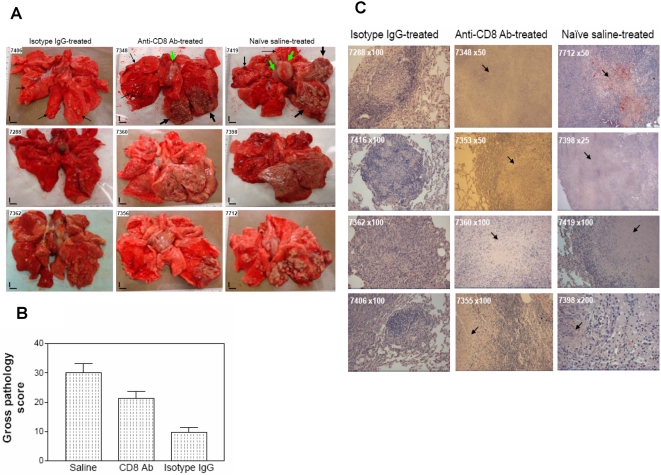
Depletion of CD8 lymphocytes in CD8 Ab-treated macaques resulted in a significant decrease in BCG vaccine-induced immunity against tuberculosis after M. tuberculosis infection.(A) Top-panel photos show that the isotype IgG-treated BCG-vaccinated macaque (7406) exhibited limited numbers of granulomas (small arrows) in the cut-section of the right caudal lobe; the CD8 Ab-treated macaque (7348) showed extensive tuberculosis granulomas (large arrows) in the right caudal lobe, with a unilaterally enlarged hilar lymph node (a large green arrow). A naïve macaque (7419) showed large extensive tuberculosis lesions with caseation (large arrows), and much larger bilateral hilar lymph nodes (large green arrows). Middle- and bottom-panel photos show tuberculosis lesions in cut-sections of lungs of six monkeys in three respective groups. Extent and severity of the lesions could be adjudged based on the examples pointed by arrows at the top panel photos. Overall, CD8 Ab-treated macaques exhibited greater numbers of lung lobes displaying extensive coalescing granulomas than isotype IgG-treated control animals (p<0.05, by nonparametric t test). The CD8 Ab-treated macaques also showed more lobes with extensive caseating and miliary lesions or caseation pneumonia than the isotype IgG-treated controls (p<0.05, by nonparametric t test). Tuberculosis lesions in the CD8 Ab-treated macaques were more likely distributed or disseminated in other lobes or opposite lungs and hilar nodes/pleural. Small vertical/horizontal bars at bottom-left corner of each photo represent the 1-cm scale derived from the fluorescence rulers of each original photo. (B) Gross pathology scores of tuberculosis lesions in CD8 Ab-treated group, Isotype control IgG-treated group and naïve saline-treated group of macaques. Each macaque was given a total gross pathology scores based on the tuberculosis lesions in thoracic and extrathoracic organs. The mean gross pathology score was then calculated for each group of macaques and subjected to statistical analysis. *, P<0.05 (by ANOVA and nonparametric t test) for comparison between CD8 Ab-treated and isotype control IgG-treated groups, and for comparison between CD8 Ab-treated and naïve groups. (C) Histology evaluation of lung tissue sections of CD8 Ab-treated, isotype control IgG-treated and naïve saline-treated macaques. Shown are H&E stained sections taken from four representative macaques for each group, with macaque ID and magnification indicated for each image. Note that the isotype control IgG-treated macaques exhibited well-contained granulomas, which were generally infiltrated by numerous lymphocytes and some neutrophils. The CD8-depleted macaques displayed less-contained granulomas that were more likely to be necrotic (arrows). Naïve macaques showed less lymphocytic and more necrotic tuberculosis lesions than the other two groups.